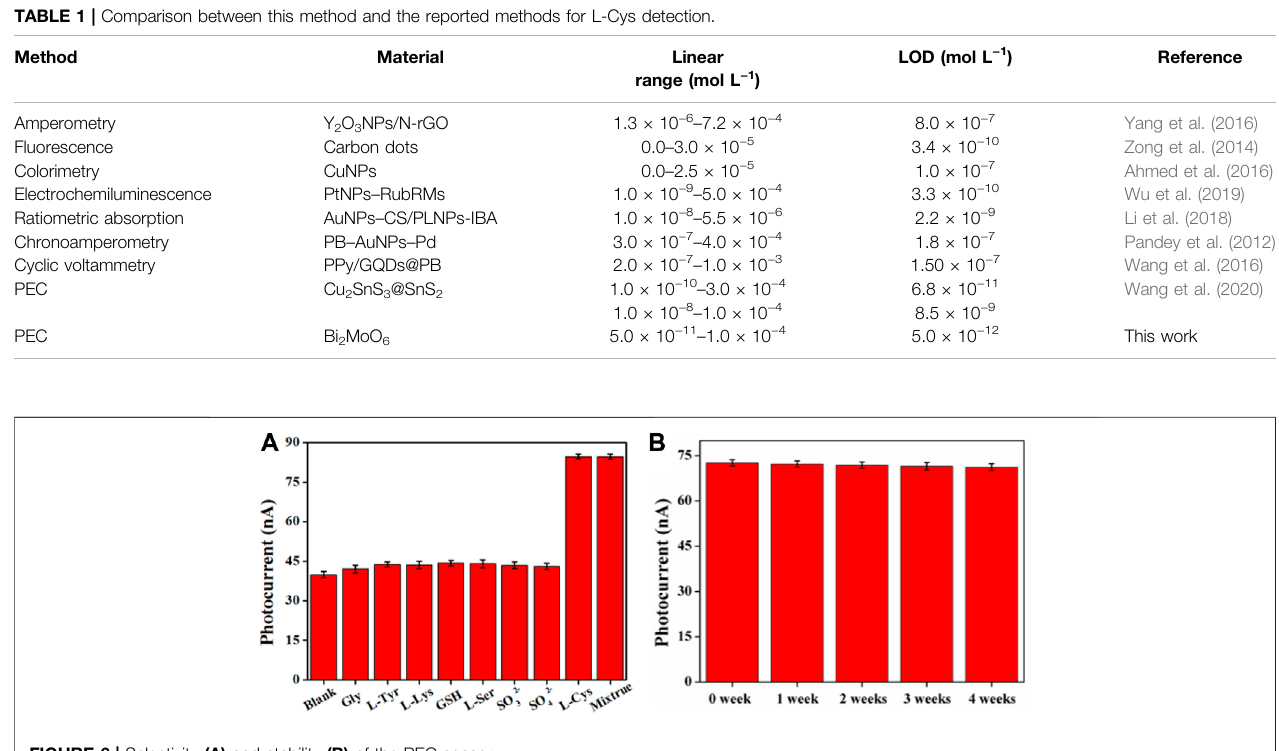
FIGURE 6 | Selectivity (A) and stability (B) of the PEC